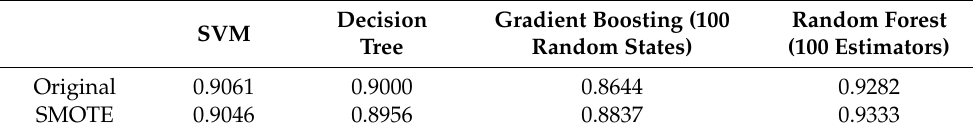
Table 2. Gaze classification accuracy table.